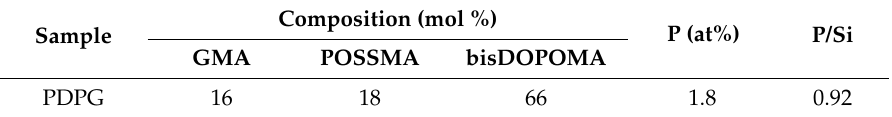
Table 1. Composition and structure information of PDPG calculated by 1 HNMR measurement.